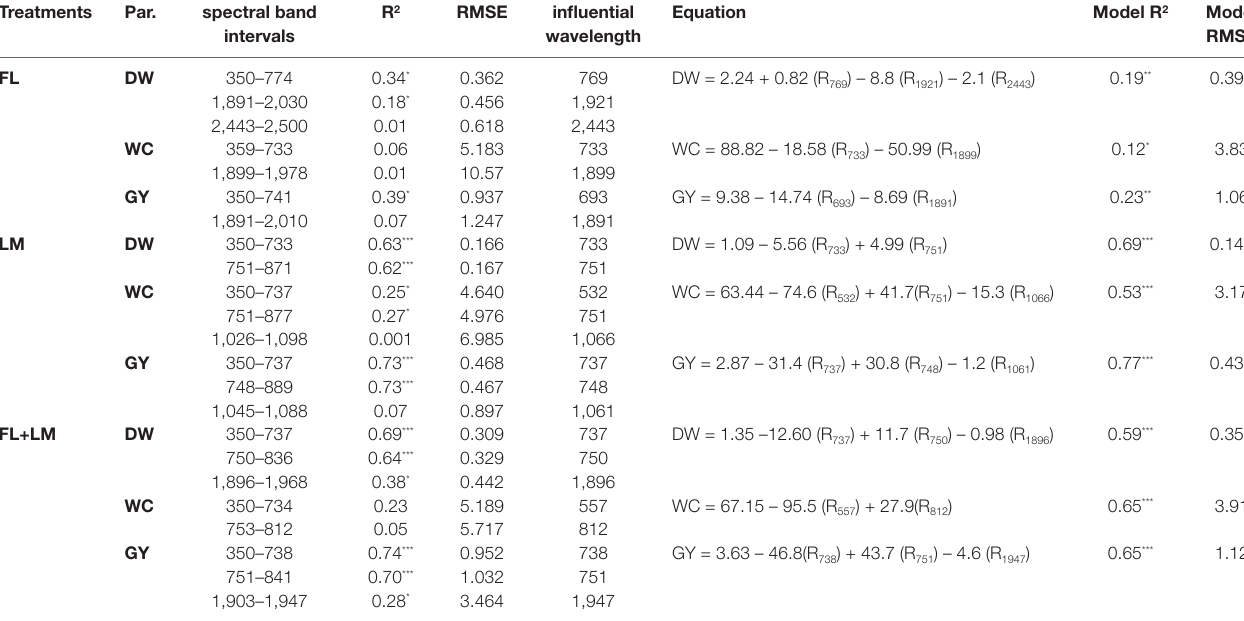
TABLe 2 | Extraction of the important sensitive spectral band intervals based on the variable importance in projection (VIP) and loading weights of partial least square regression (PLSR) analysis over full wavelengths as well as the most influential wavelengths and their models using the stepwise multiple linear regression (SMLR) for the three measured parameters [shoot dry weight per square meter (DW), water content of aboveground biomass (WC), and grain yield per hectare (GY)] under full irrigation (FL), limited irrigation (LM), and the combined two treatments (FL+LM). Treatments